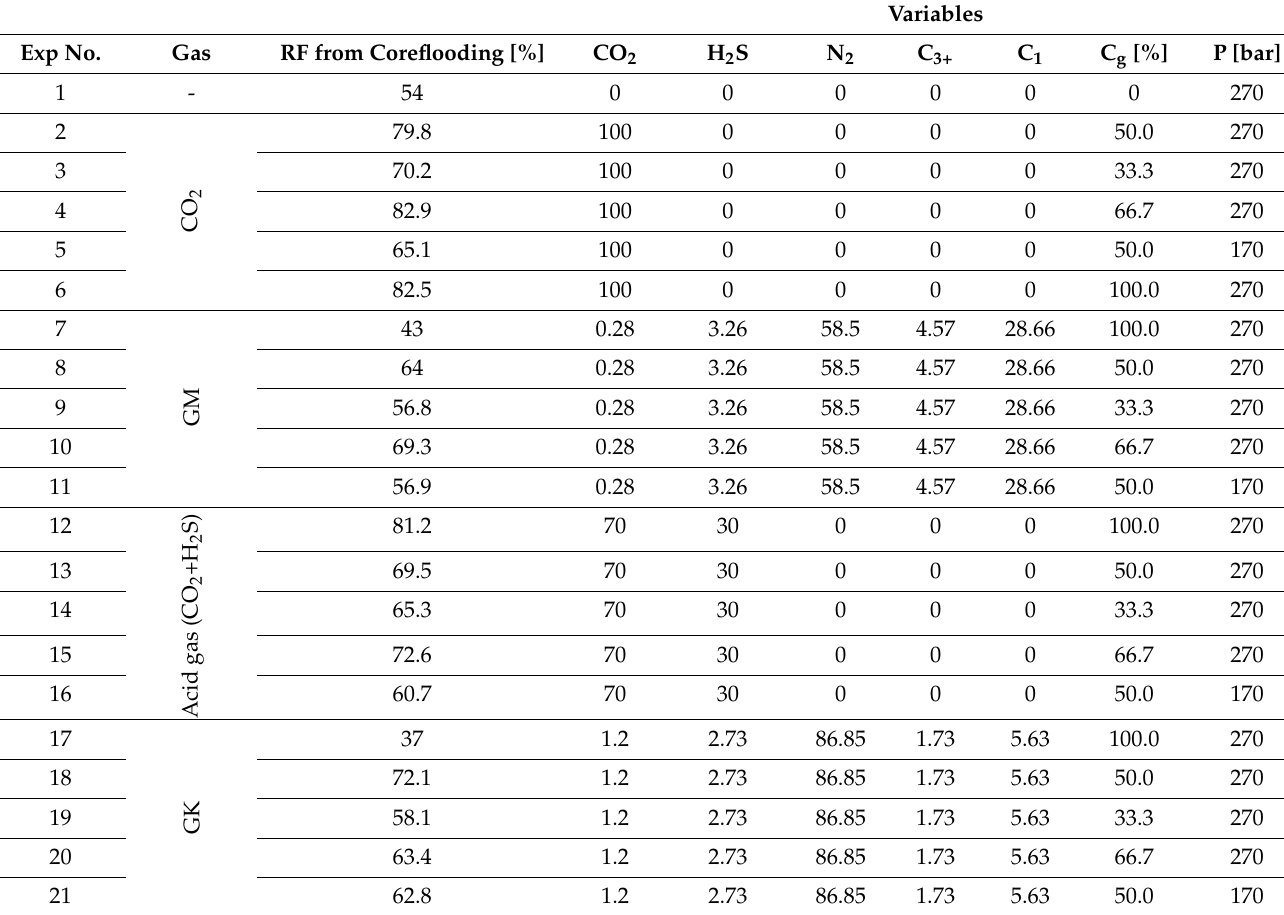
Table 11. Input and output data used in